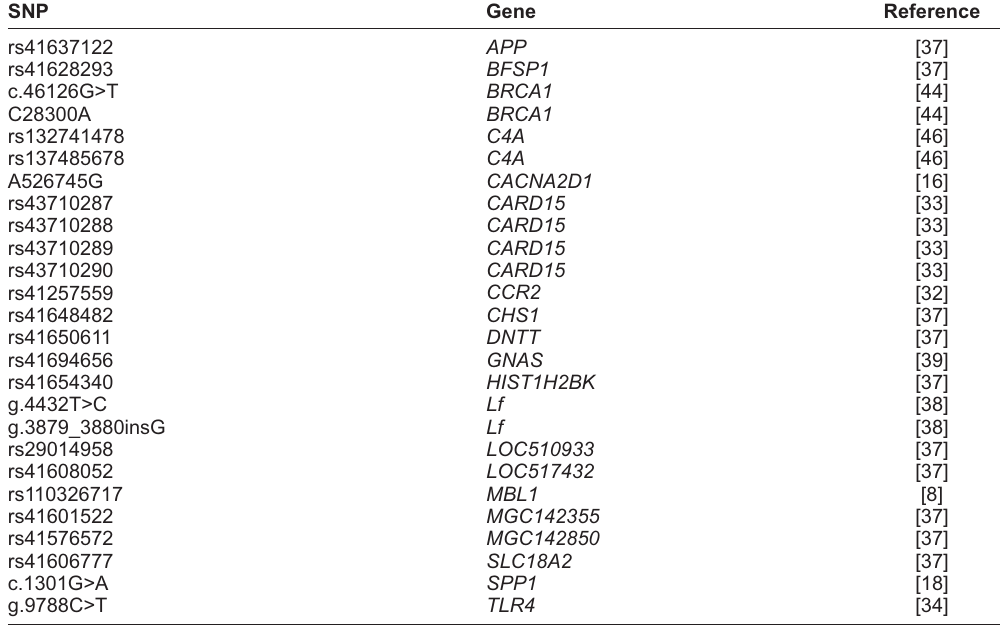
Table-1: Various single nucleotide polymorphisms that are found to be significantly associated with mastitis tolerance SNP